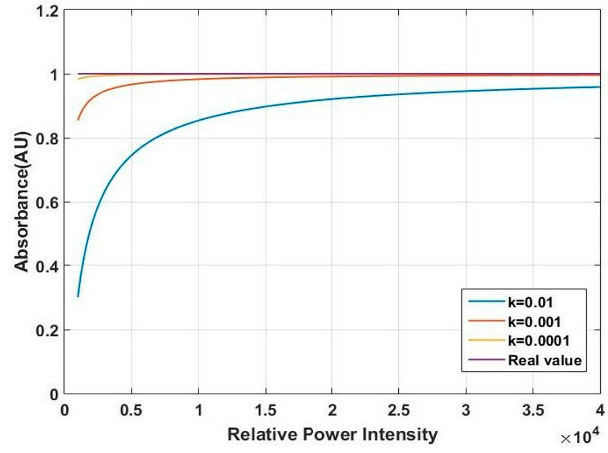
Figure 5. Influence of stray light on the low-energy wavelength band.